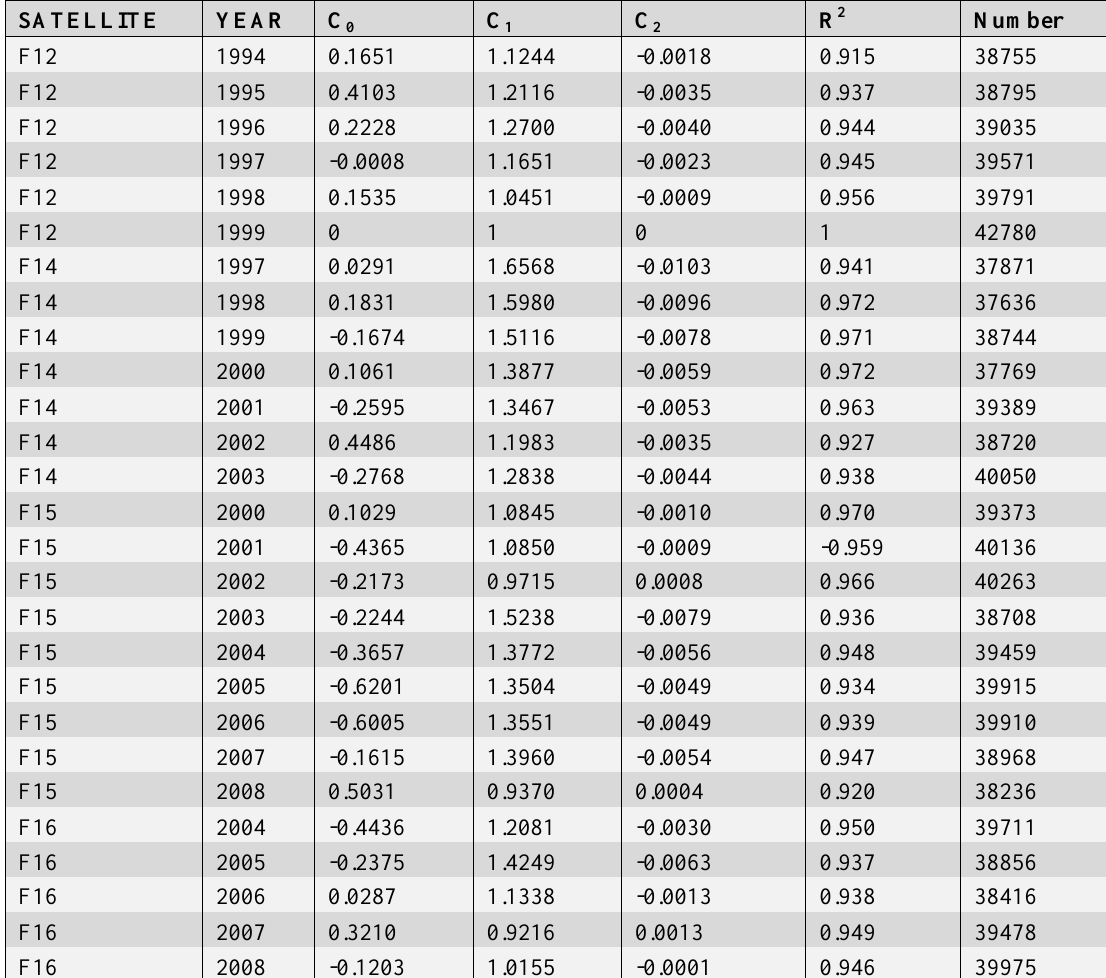
Table 2. Equations for intercalibrating the annual nighttime lights products. The adjusted digital number (DN) is created by the application of this formula. The coefficients are empirically derived by comparing images of Sicily with F12 1999 (See Figure 4).